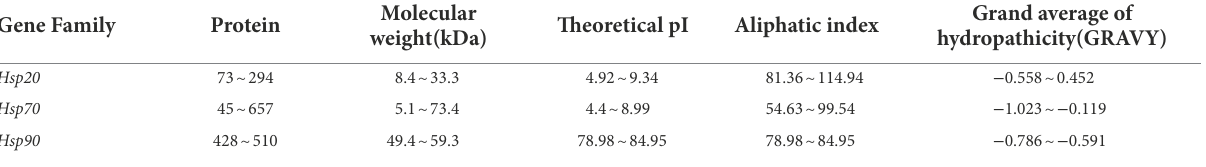
TABLE 1 The characteristics of Hsp20 , Hsp70 and Hsp90 members identified in Dendrobium officinale. Gene Family